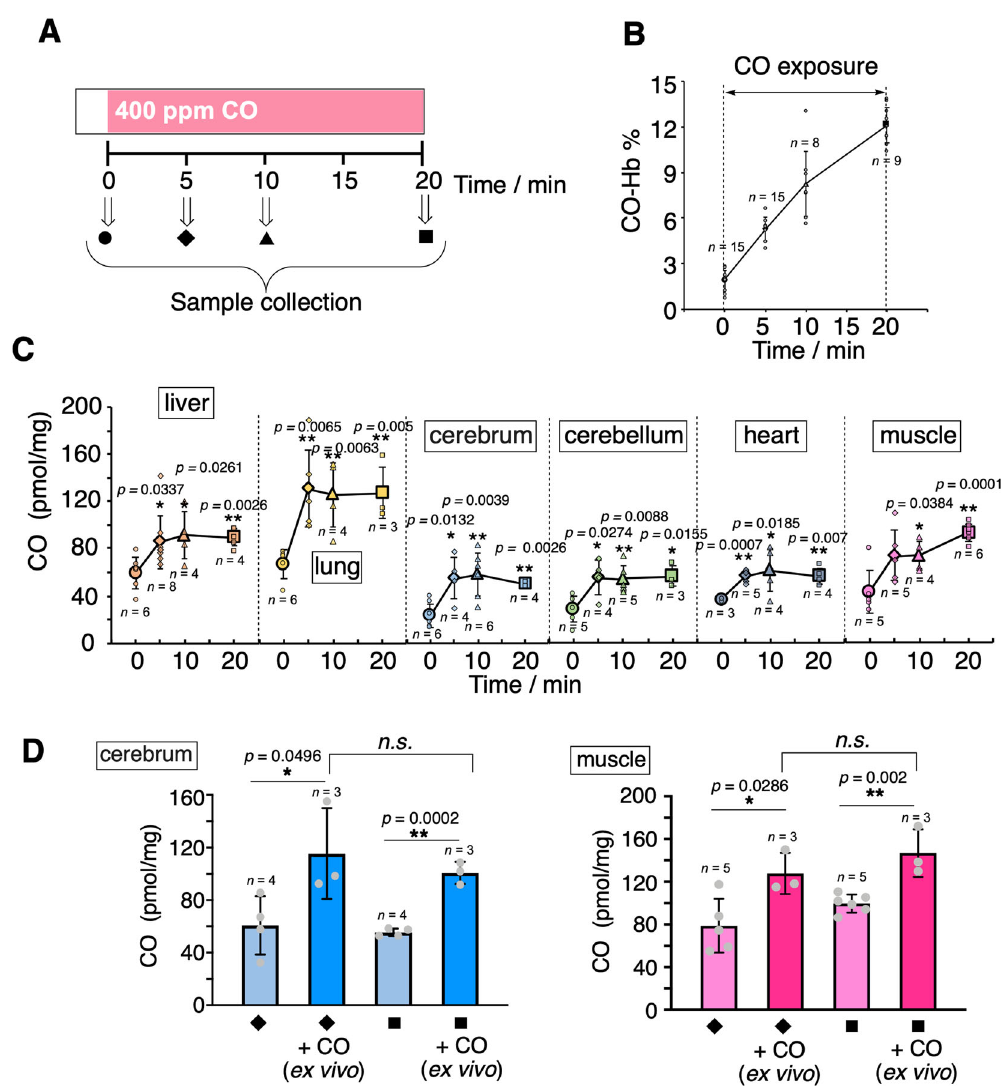
Fig. 5 Kinetic studies of CO levels in blood and tissues after exposure to CO in rats. A Anesthetized rats were exposed to CO inhalation (400 ppm) and samples collected at different times as shown. B Changes in CO-Hb (%) in the venous blood collected from right ventricles as a function of time. C Tissue CO contents as a function of time. Each plot represents the mean ± SD ( n = 3 – 6, the number of experiments is shown in the panel). Statistical signi fi cance, * p < 0.05, ** p < 0.01 versus t = 0. D Amount of CO in muscle and cerebrum before and after purging CO gas ex vivo. Samples collected at 5 or 20 min were placed under CO atmosphere for 1 h and then assayed for CO content. Each bar represents the mean ± SD ( n = 3 – 5, the number of experiments is shown in the panel). Statistical signi fi cance, * p < 0.05, ** p < 0.01; n.s. not signi fi